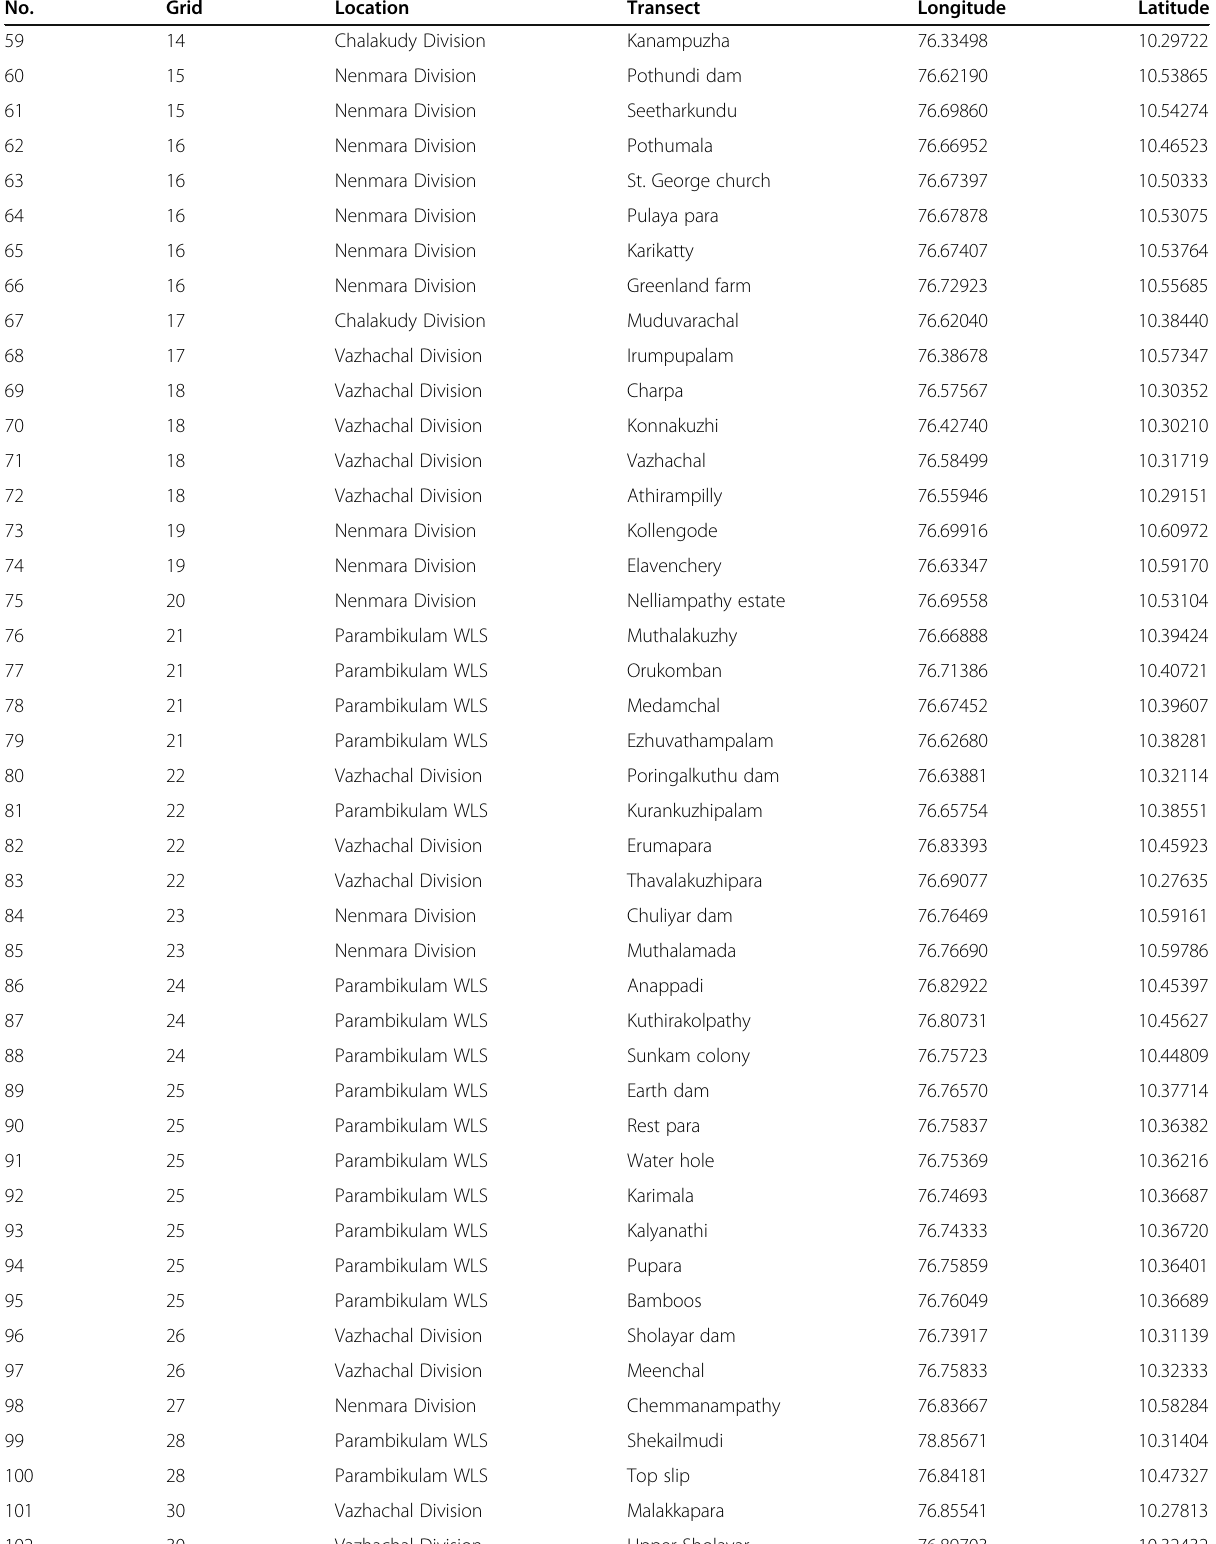
Table 1 Geographic coordinates of transects sampled in 30 grids of study area (Continued)